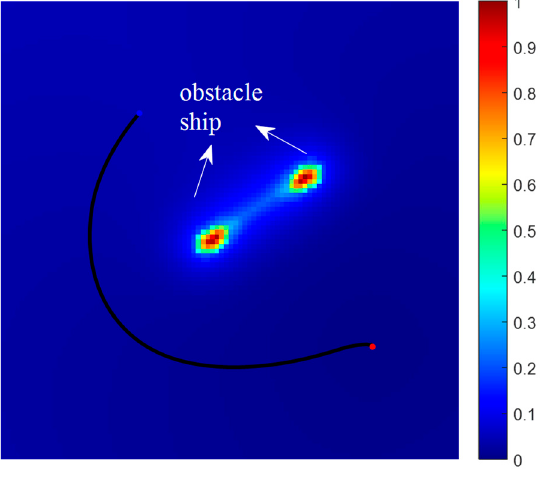
Figure 2. The planned path.